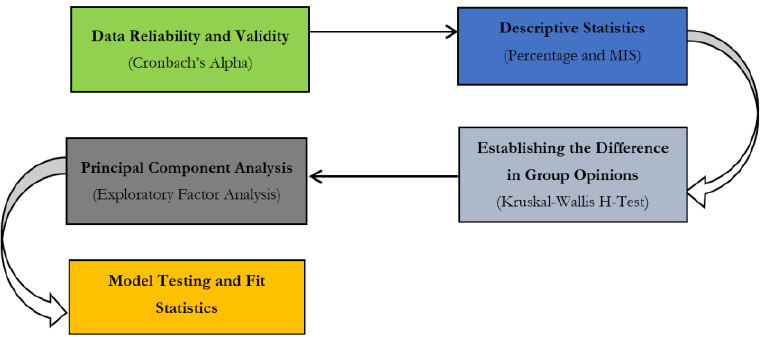
Figure 1. Framework for Data